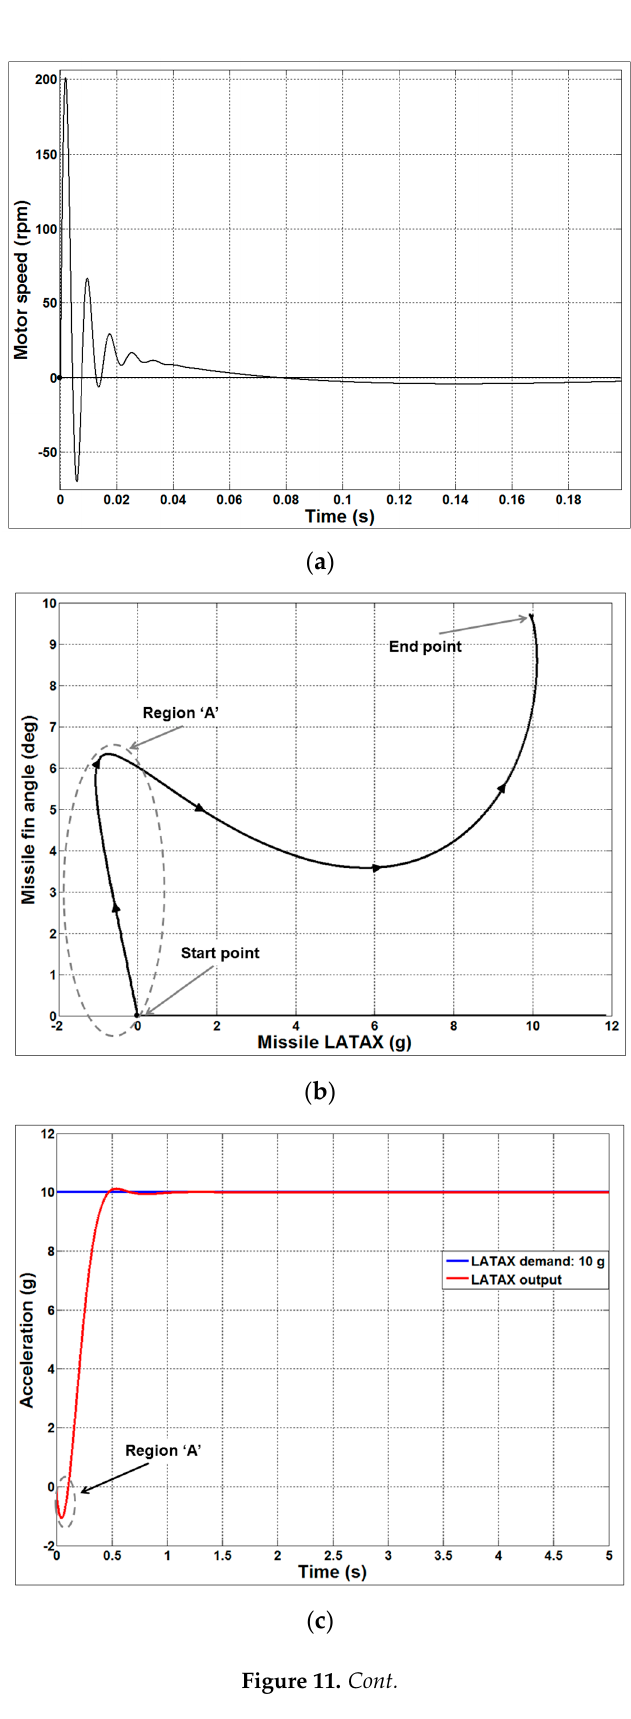
Figure 11. Cont. Figure 11.